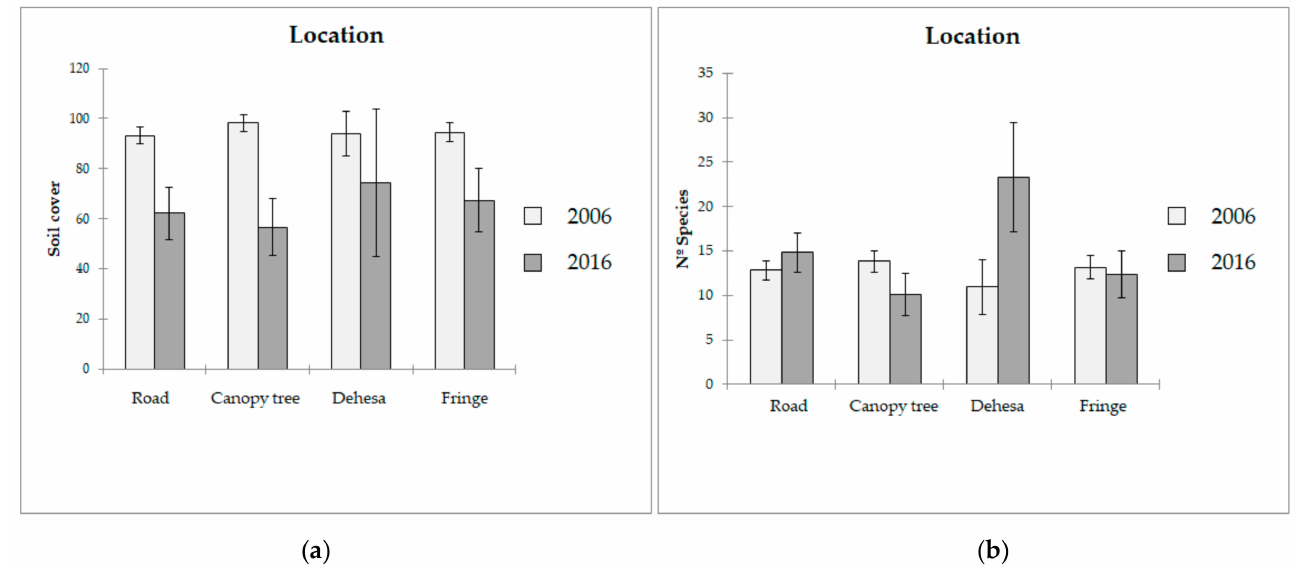
Figure 8. ( a ) Variation in soil cover depending on the gradient of human intervention ( dehesa cover > fringe cover > road cover > tree canopy cover) in the two time periods over 2006–2016. (The error bars show the standard error). ( b ) Variation in number of species depending on the gradient of human intervention ( dehesa cover > fringe cover > road cover > tree canopy cover) in the two time periods over 2006–2016. The error bars show the standard error.